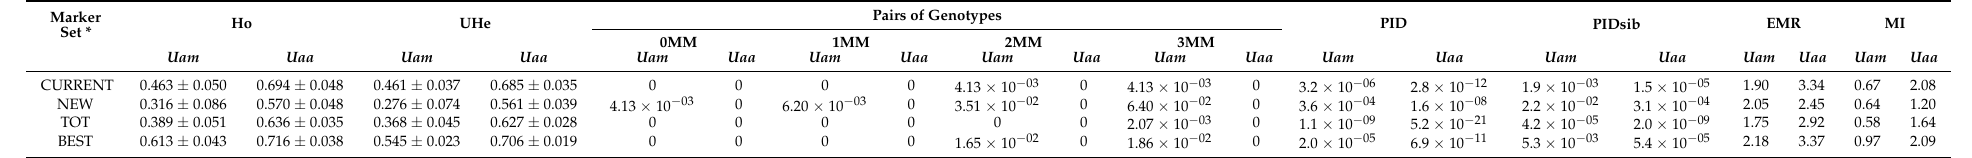
Table 4. Estimates of genetic variability in the four different STR sets compared in this study for U. a. marsicanus ( Uam ) and U. a. arctos ( Uaa ). The microsatellite panel widely used in Italian monitoring projects (CURRENT), the new set of loci tested in this study (NEW), the complete set of loci (TOT), and the loci with the highest resolution power in individual identification (BEST) are shown. Mean value of observed heterozygosity (Ho), mean value of unbiased expected heterozygosity (UHe), pairs of genotypes that match at all loci (0MM) and at all but 1-2-3 loci (0-1-2-3 MM), probability of identity for unrelated individuals (PID), probability of identity for siblings (PIDsib), effective multiplex ratio (EMR), and marker index (MI) are also listed for U. a. marsicanus ( Uam ) and U. a. arctos ( Uaa